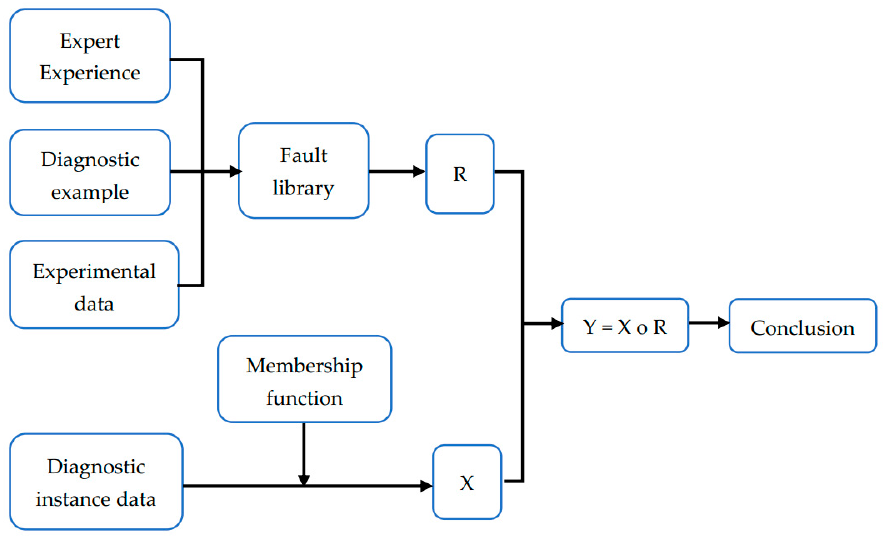
Figure 4. Schematic diagram of the fuzzy logic diagnosis method.